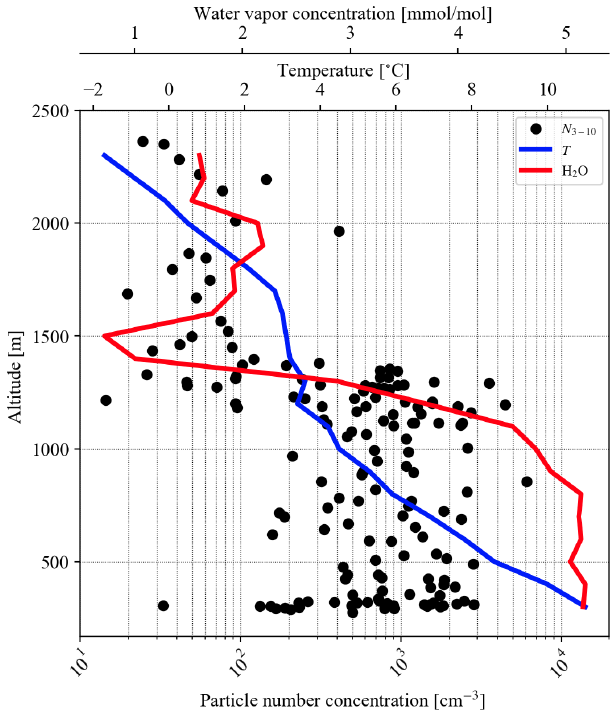
Figure 7. Vertical profile of 3–10nm particle number concentration (black dots), temperature (blue line) and water vapor concentration (red line) measured on board the Cessna between 07:00–10:00 on 8 May 2013 in